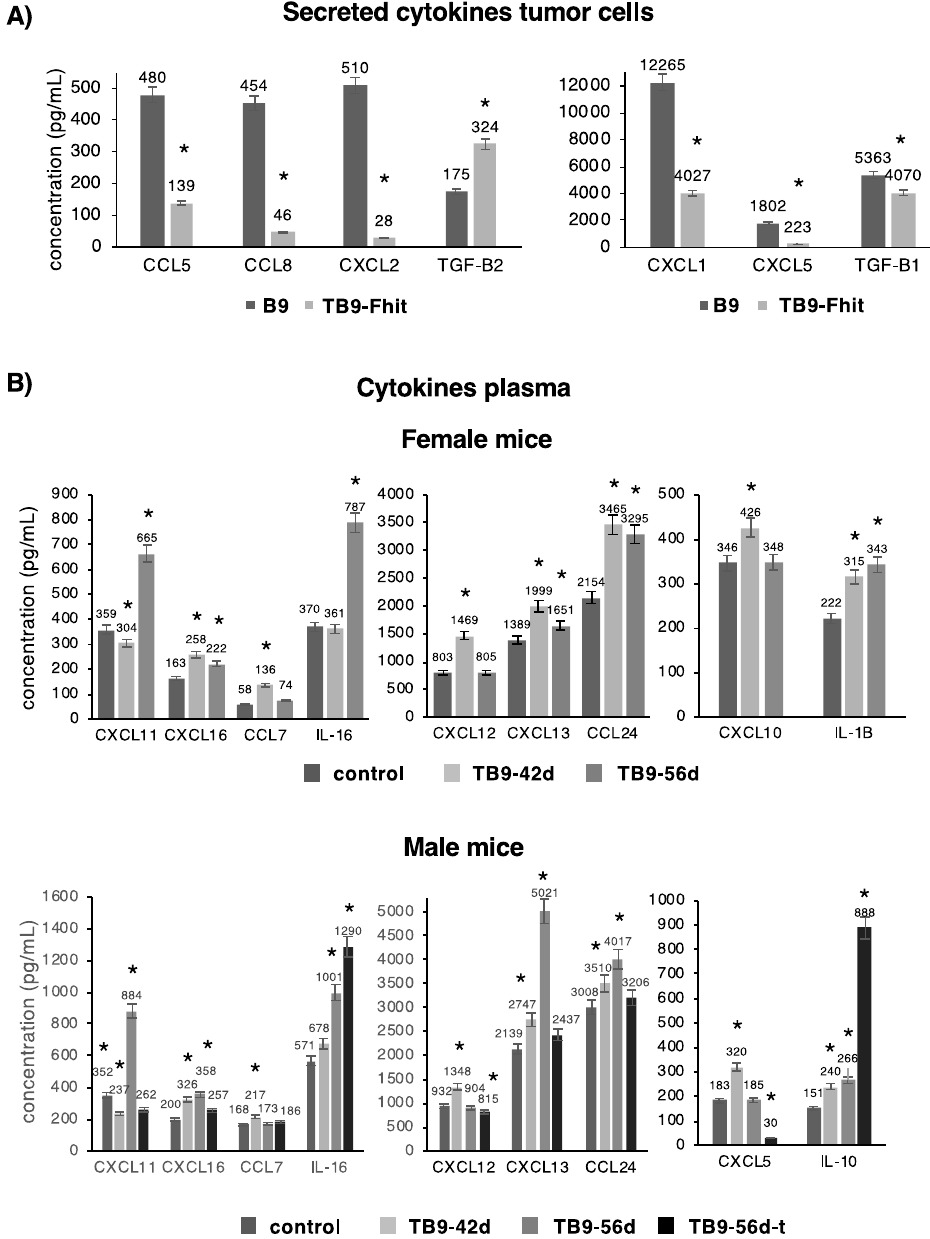
Figure 4. The cytokine / chemokine profile in untransfected and Fhit-transfected tumor cells and in mice inoculated with Fhit-transfected tumor cells. ( A ) The cytokine / chemokine profile secreted by Fhit-transfected versus non-transfected tumor cells. Fhit transfection of tumor cells modified the pattern of cytokine / chemokine secretions; ( B ) The cytokine / chemokine profile in plasma of female / male mice inoculated with Fhit-transfected tumor cells versus control mice. Results show chemokine / cytokine levels at 42 (42d) and 56 (56d) days post-inoculation of tumor cells. The male mice with primary tumor are depicted as 56d-t. Only cytokines / chemokines presented changes in their expression are depicted. Di ff erences were found between female and male mice and between male mice with and without a primary tumor. Values are depicted as means ± SD of two independent experiments performed in duplicate. * p < 0.05. A two-tailed Student’s t -test or ANOVA test, followed by Tukey’s post-hoc test, was used for statistical